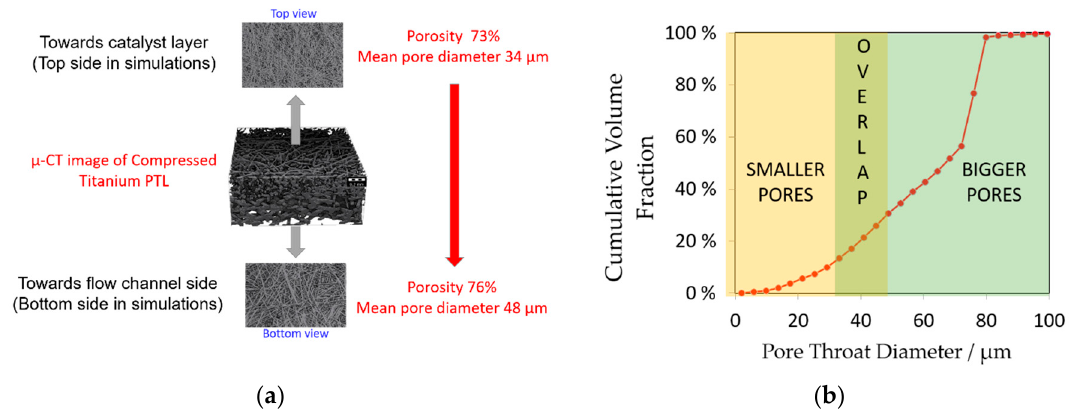
Figure 2. ( a ) Compressed titanium felt (from SylaTech Germany; d fibre = 20–45 µm, thickness 1.02 mm, original porosity 80%) after application at the anode in water electrolysis. The pore sizes at the top side are smaller than throughout the rest of the material. This results in different porosities at the top and bottom sides. The images were obtained from microcomputed tomography (CT-Alpha from Procon X-Ray GmbH, Sarstedt, Germany). ( b ) Cumulative volume fraction of measured pore sizes. The region denoted as “smaller pores” refers to the top side of the felt and the region denoted as “larger pores” refers to the bottom side, cutting the felt in half at its horizontal axis. Both layers have an overlap of pore sizes as indicated. PTL denotes the porous transport layer.